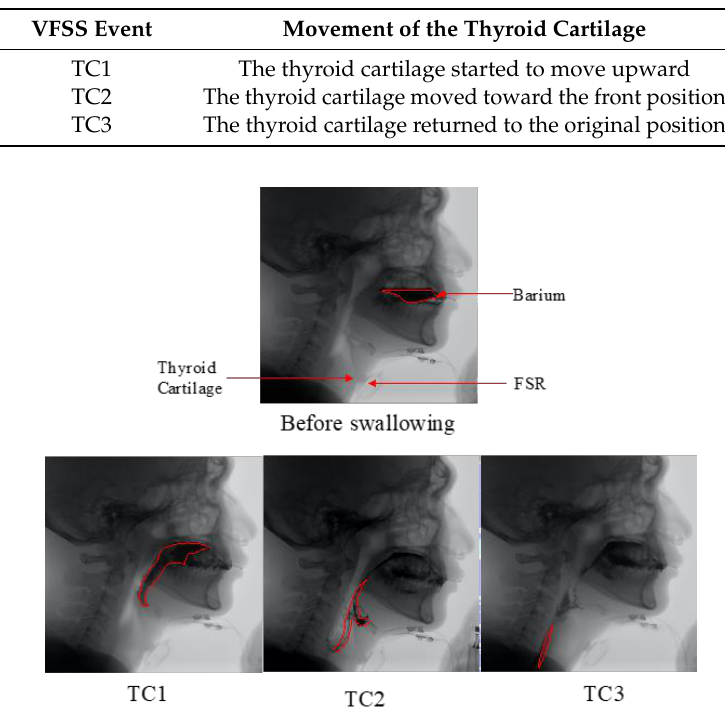
Figure 6. Sequential VFSS captures: Before swallowing, TC1, TC2, and TC3. The positions of the thyroid cartilage and the FSR were labeled in the first capture.